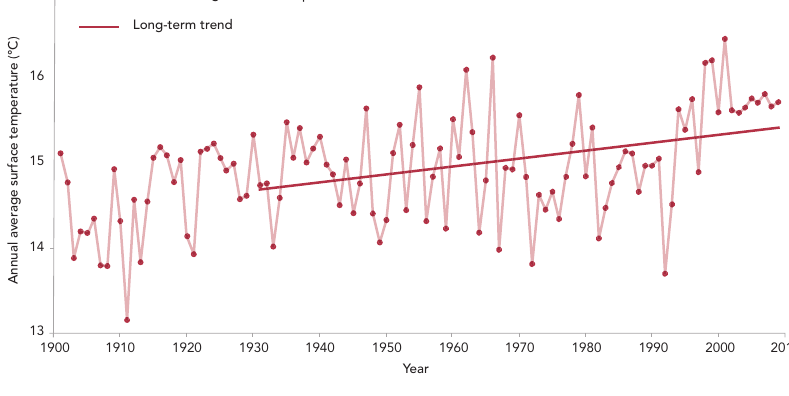
Figure 3. Temperature (1901–2009): Temperature has shown a long-term increasing trend in the Fertile Crescent. Every year from 1994 through 2009 was warmer than the century-long average for the